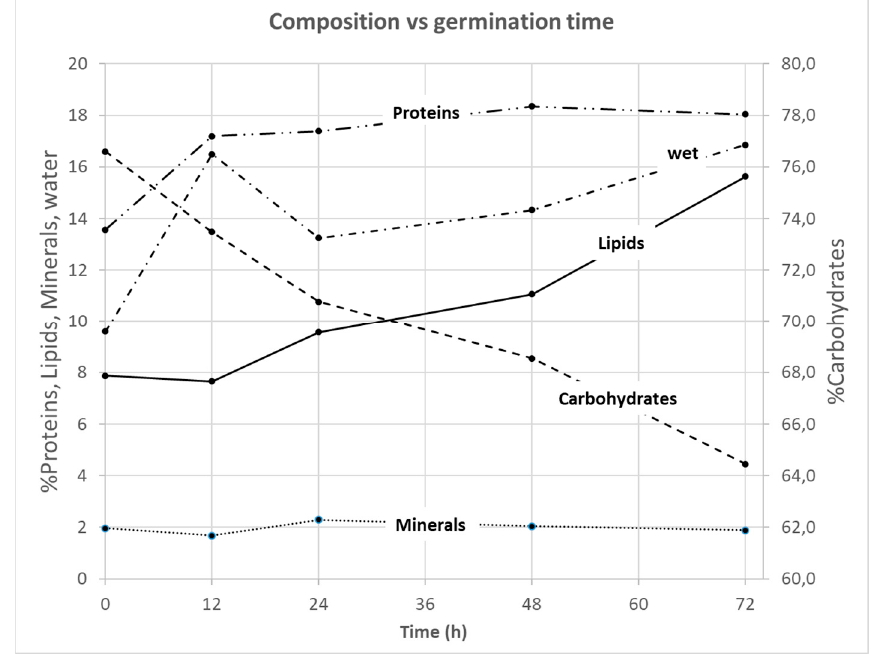
Figure 1. The change in proximate composition of quinoa flours along the germination time. All values expressed in dry